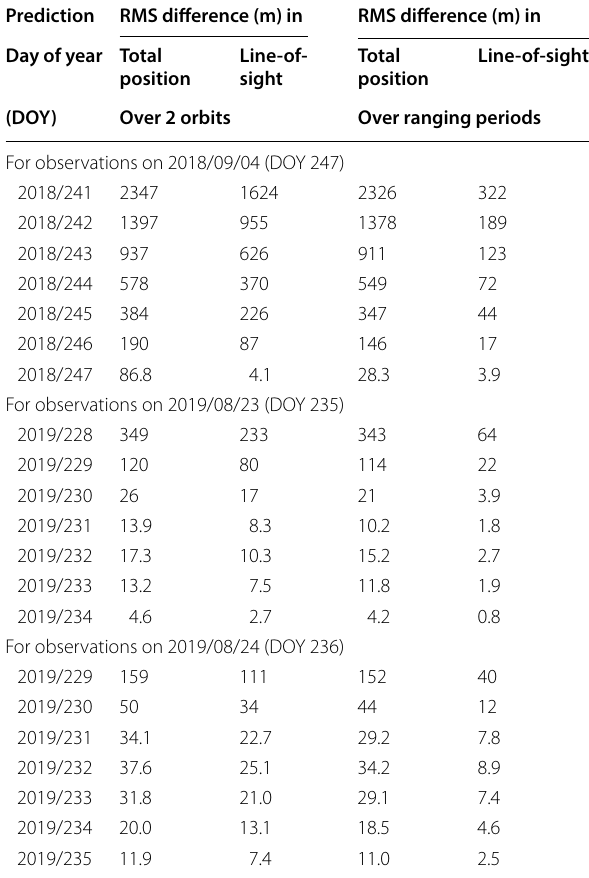
Table 2 RMS of orbit differences between predictions and reconstruction in total position and along the line‑of‑ sight between Grasse and LRO. Orbit predictions and time periods are the same as in Fig.